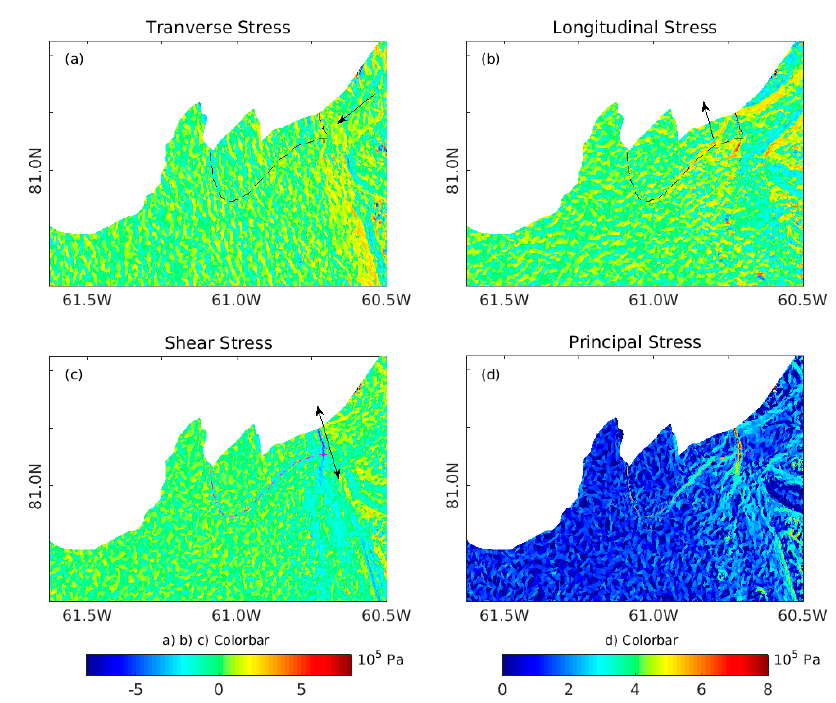
Figure 5. Ice stress condition distribution at the glacier’s terminus corresponding to the period of Figure 3c (average daily stress from 18 July to 24 July in 2017) before the calving event. ( a ) The transverse stress, ( b ) the longitudinal stress, ( c ) the shear stress and ( d ) the first principle stress.